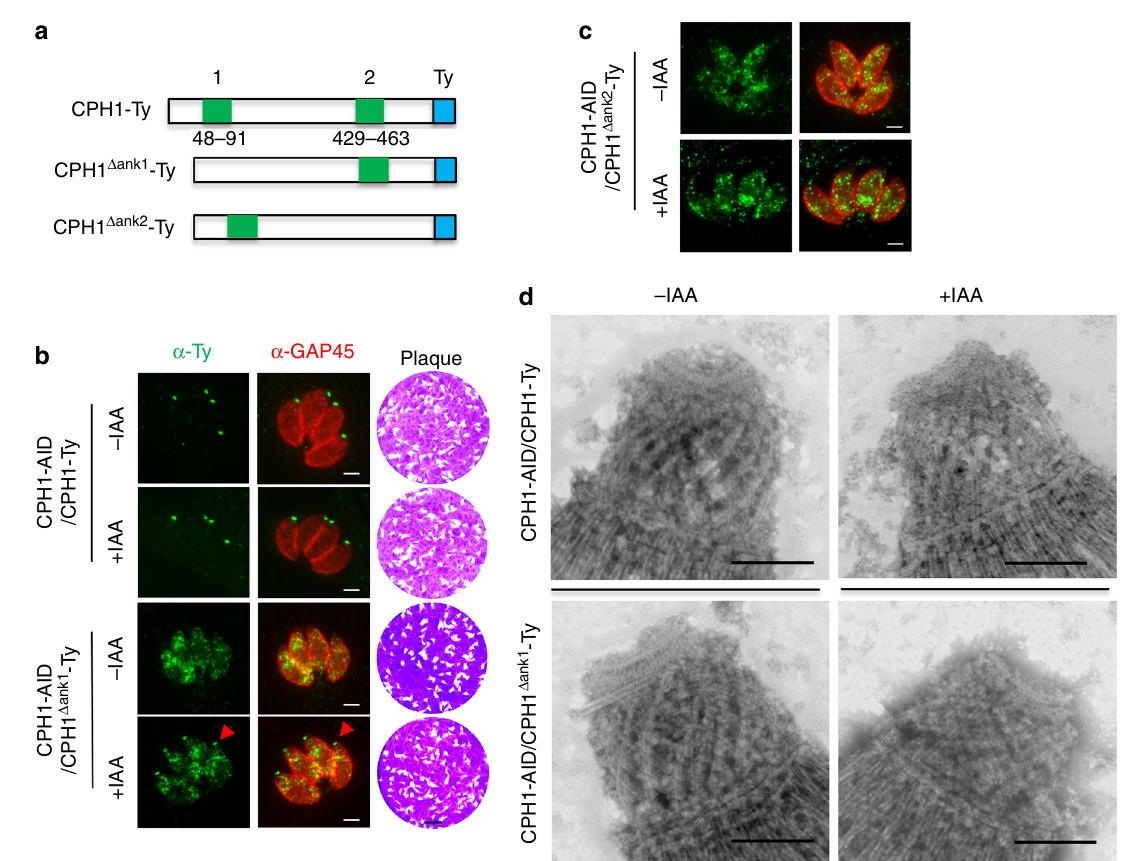
Fig. 4 Ankyrin repeats target CPH1 to the conoid and are critical for function. a Model of CPH1 complementation constructs. The ankyrin repeat 1 (48 – 91) or ankyrin repeat 2 (429 – 463) were deleted from the wild-type copy CPH1-Ty to create copies of CPH1 Δ ank1 -Ty and CPH1 Δ ank2 -Ty, respectively. b Expression of stable complementing lines in the CPH1-AID line. Localization by IFA (left) following culture in ± IAA for 24 h, scale bar = 2 µ m. Red arrows point to the partial conoid localization of CPH1 Δ ank1 -Ty. Plaque formation (right) following growth in ± IAA for 7 days (right). Scale bar = 0.5 cm. c Transient expression of CPH1 Δ ank2 -Ty, the CPH1-AID line. Localization as in b . d Conoid integrity in extracellular parasites examined by negative staining and TEM. Parasites were grown in ± IAA for 40 – 44 h, collected, and stimulated with 3 µ M A23187 for 10 min to protrude the conoid. Scale bar = 250nm. b – d Representative of three or more experiments with similar